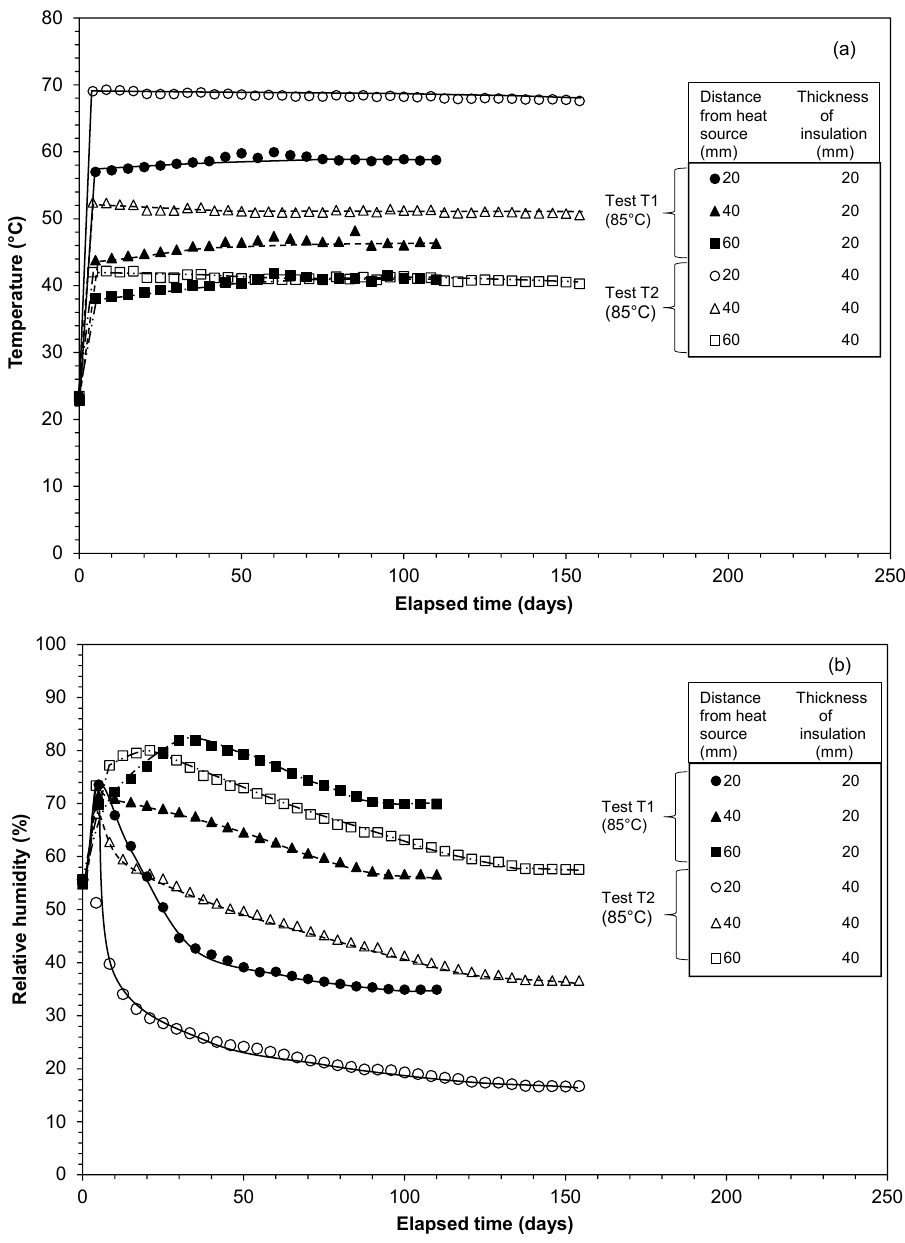
Figure 2. Effects of thermal gradient (85 °C, bottom; and 25 °C, top) on the distributions of: ( a ) temperature; ( b ) relative humidity in compacted bentonite specimens (diameter 100 mm, height 80 mm).